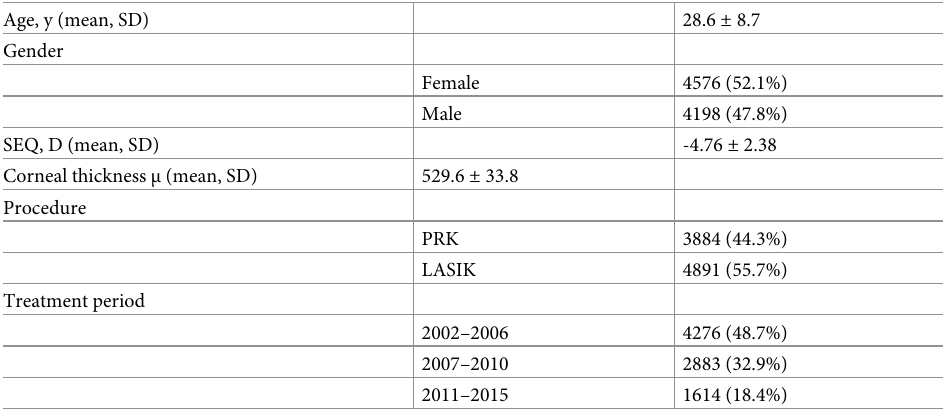
Table 1. Characteristics of the study